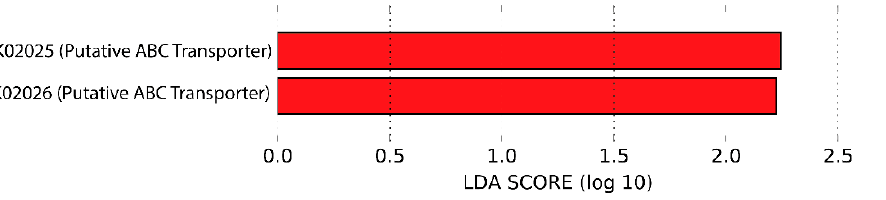
Figure 4. KEGG metabolic pathways predicted from metagenomes based on 16SrRNA gene se- quenced data (red: genotype 2: PPARG1A-2). LDA: linear discriminant quenced data (red: genotype 2: PPARG1A-2). LDA: linear discriminant analysis.